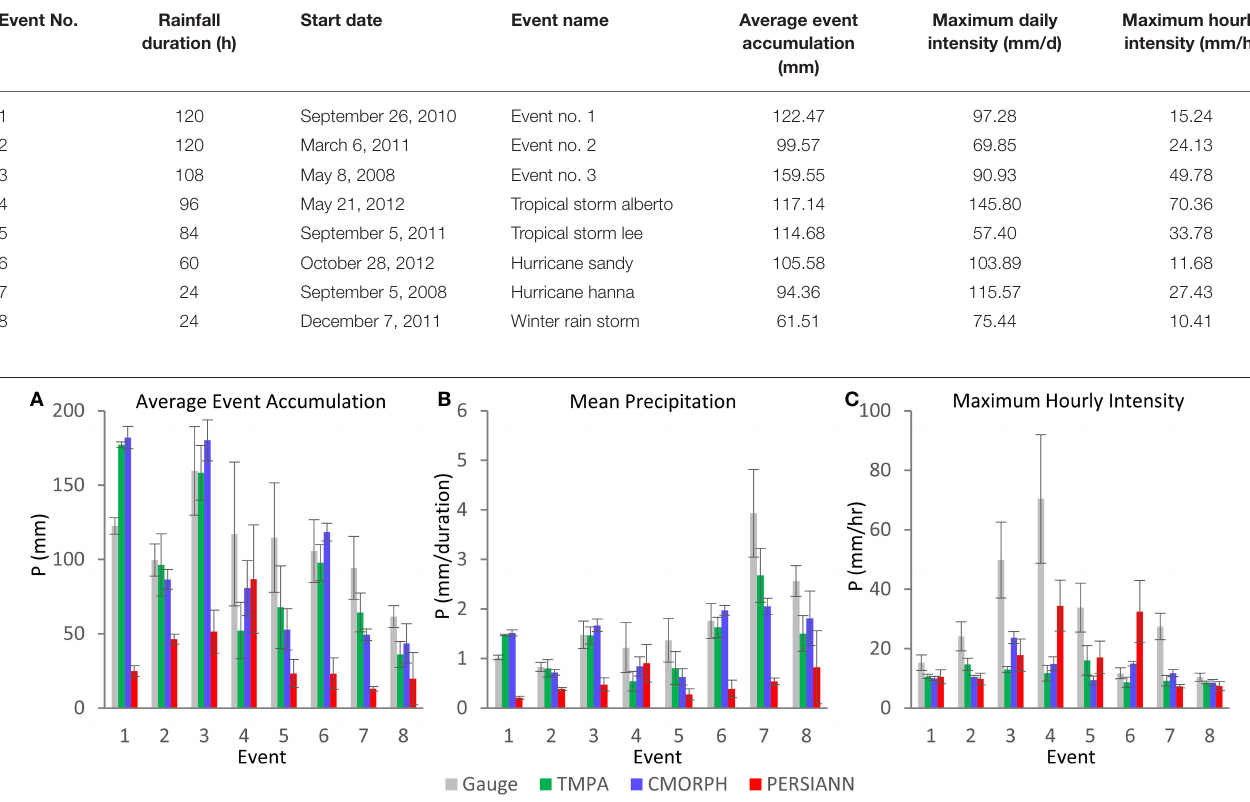
TABLE 3 | Characteristics of selected hydrometeorological events. Event